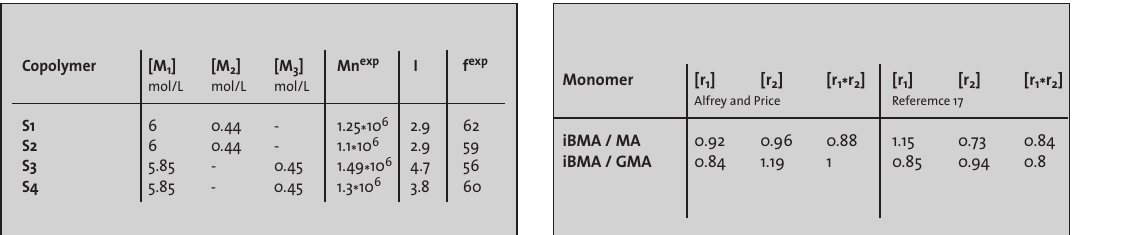
Table 1 (left): Molecular characteristics of the 4 copolymers. [M 1 ], [M 2 ], [M 3 ]: Initial concentrations of iBMA, MA and GMA in the reactive bath M– nexp ( : number average molecular weight determined from SEC (expected value: 100 000); M– /M– nexp I = : polydispersity w index determined from SEC; f exp : measured value of functionality (expected value: 50)). Table 2 (right): Reactivity ratios for the two copolymers. a: values calculated from the relations by Alfrey and Price, b: values taken from reference